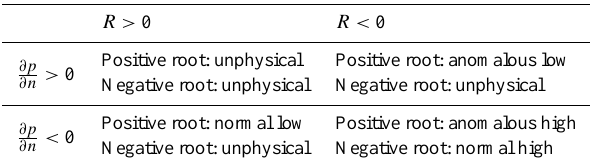
Figure 1. Force balances for the types of the gradient wind: (a) nor- mal low; (b) anomalous low; (c) normal high; (d) anomalous high. “P” represents the pressure gradient force, “Co” the Coriolis force and “Ce” the centrifugal force. Table 1. Classification of roots of the gradient wind